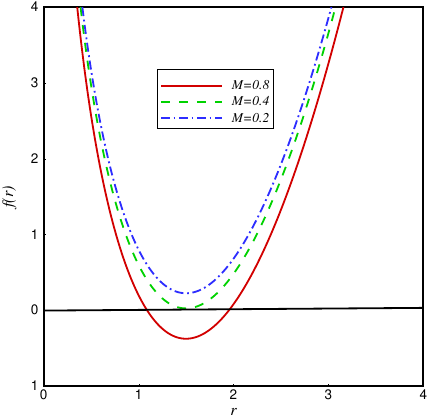
Figure 1 . The behavior of f ( r ) for charged mimetic black holes in 3D and different M . Here we have taken l = 1 and q = 1 . 5